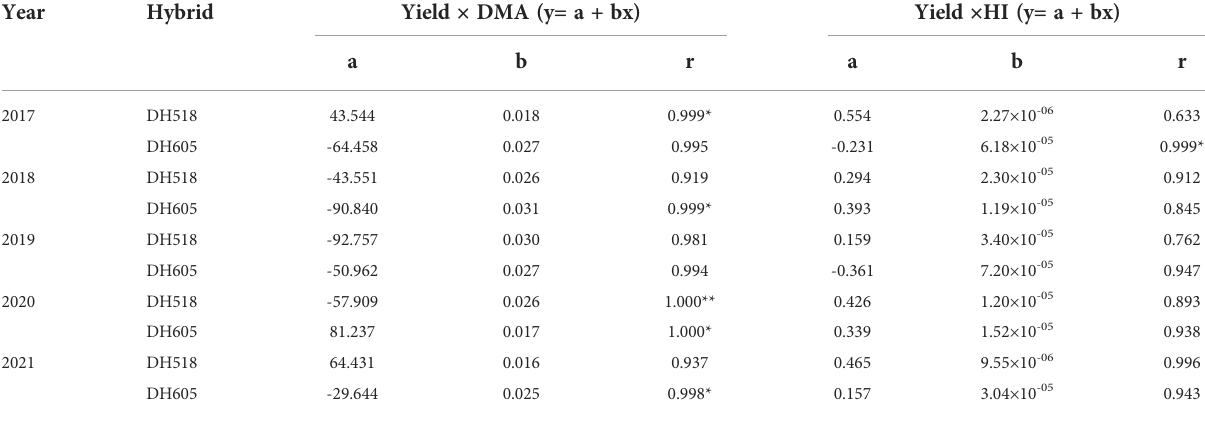
TABLE 6 Regression analysis between grain yield and DMA and HI of summer maize hybrids with different growth duration from 2017 to 2021.